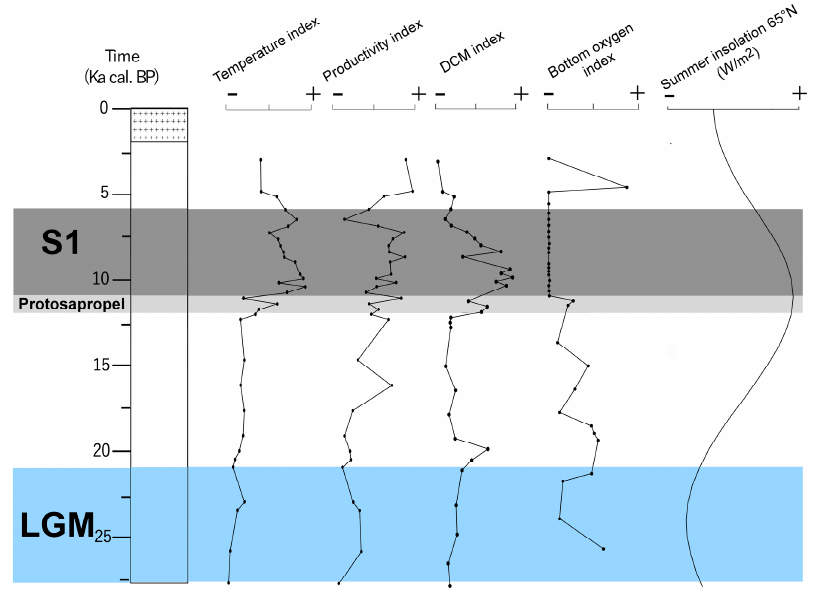
Figure 5. Micropaleontological − based and insolation indexes [58]. Raw micropaleontological results of the studied interval are reported in the (Supple- mentary Materials S1, Sections S2.2 and S2.3, Figures S2 and S3). Figure 6 summarizes